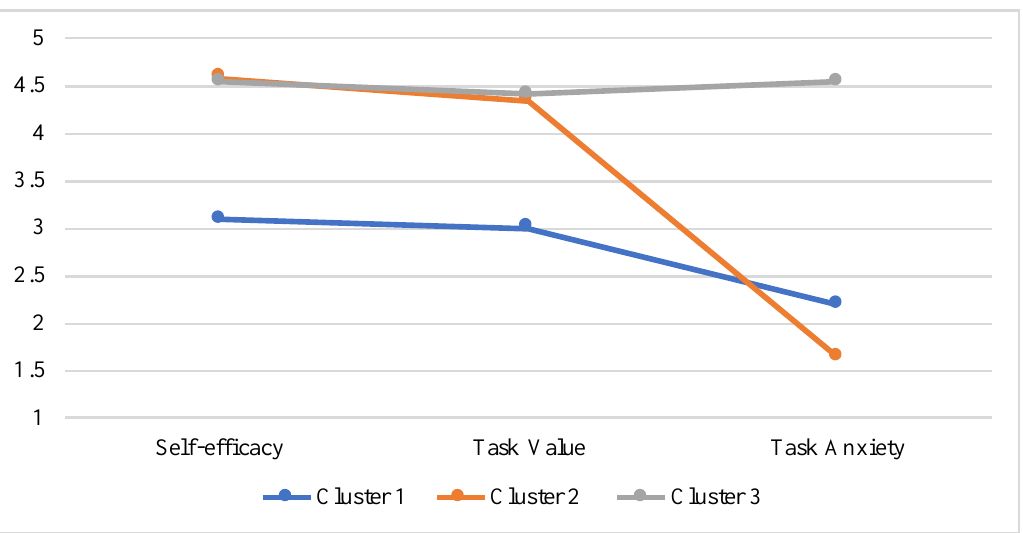
Figure 2 The three clusters of motivation profiles identified by latent profile